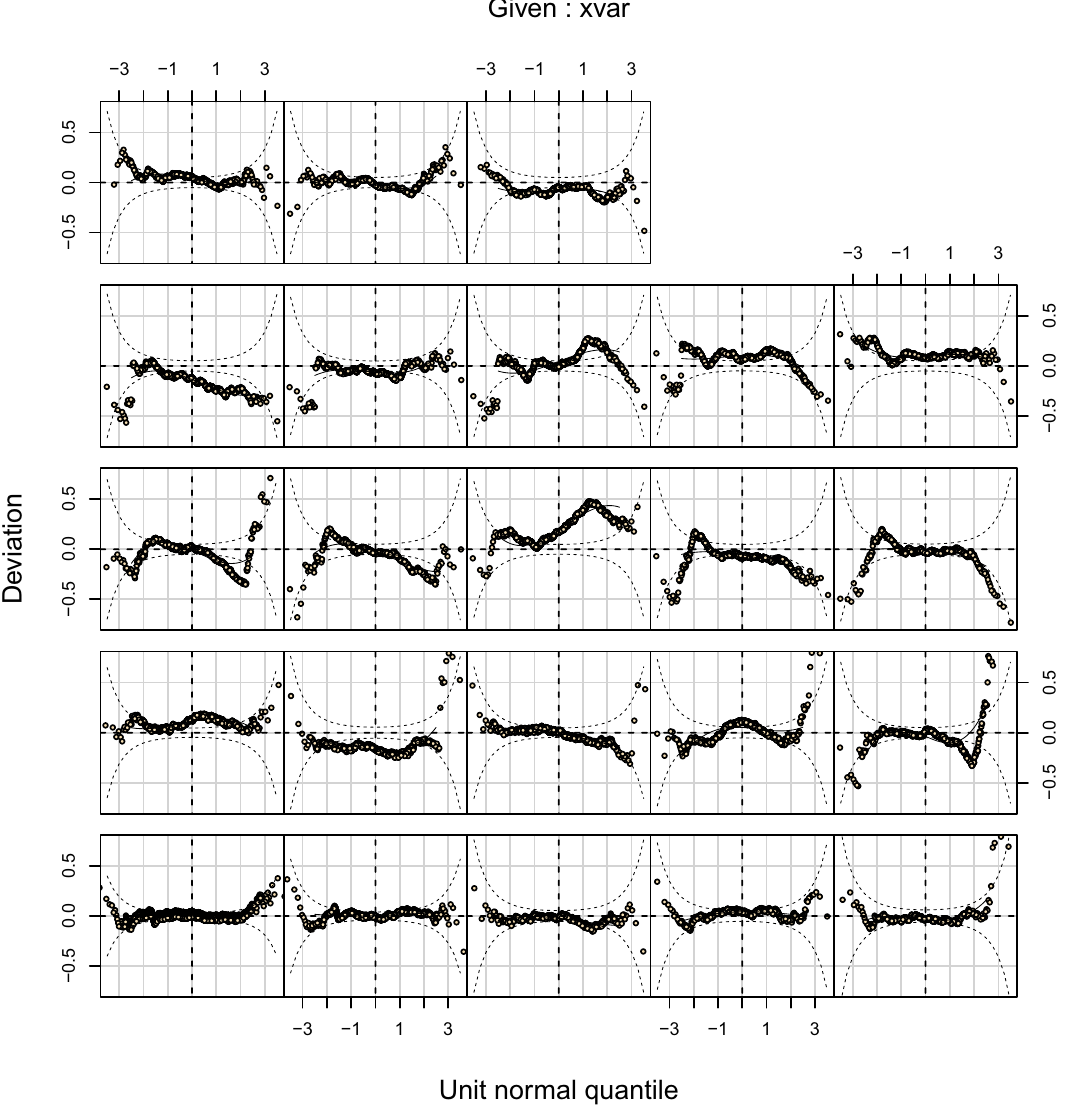
Figure 2. Worm plot for the male piglets for the LMS model. Each panel corresponds to an age bin ordered from bottom-left to